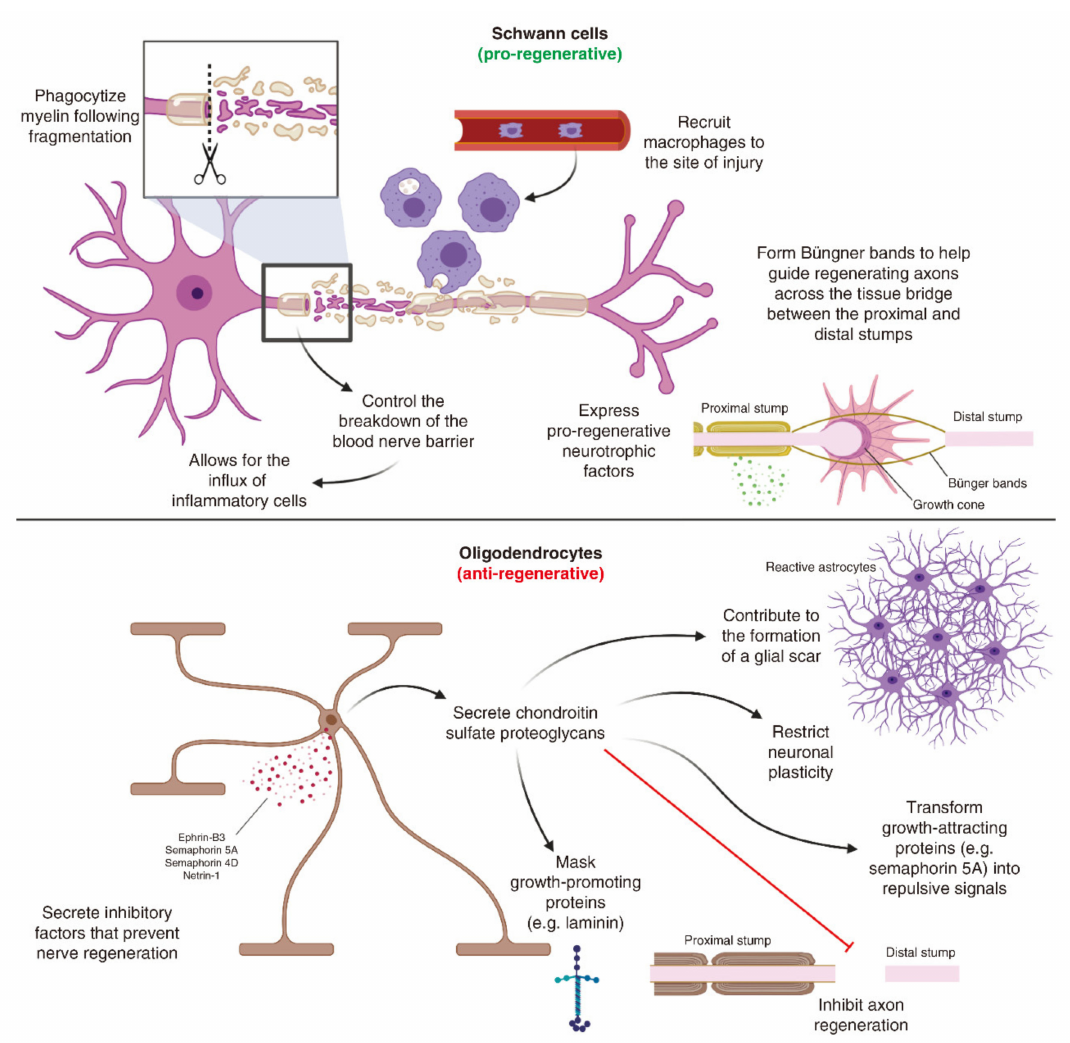
Figure 1. Comparing the role of Schwann cells and oligodendrocytes in nerve regeneration. Adapted with permission from Ref. [16]. Copyright 2021, Future Medicine